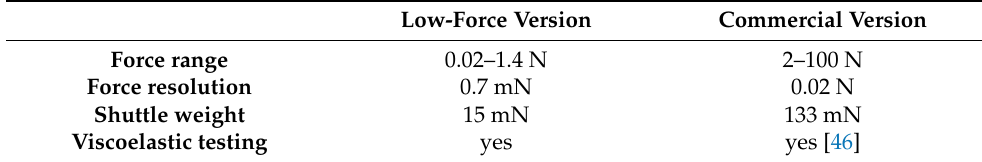
Table 2. Comparison between the low-force and commercial MCTR bioreactor performance.